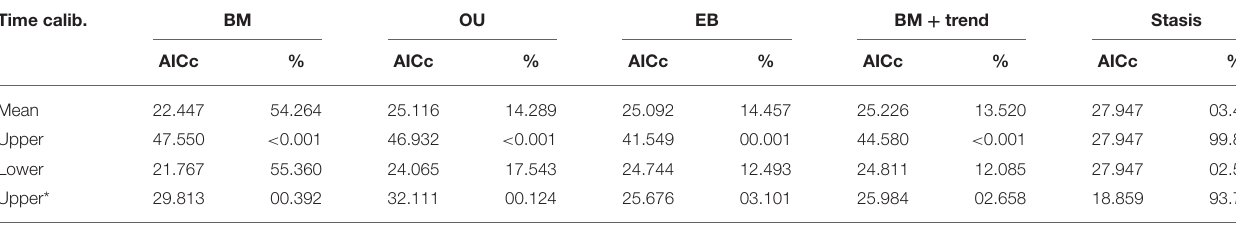
TABLE 2 | Fit of four different models to the body size evolutionary history of Rhynchosauria. Time calib.